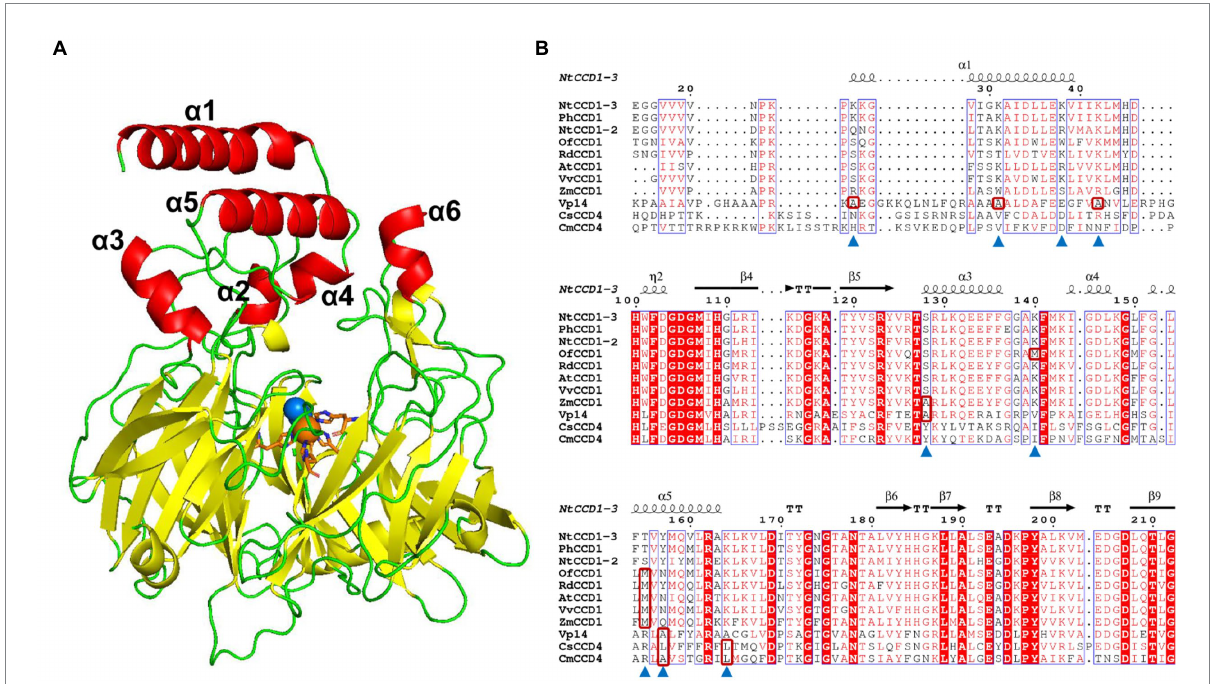
FIGURE 5 The simulated structure of NtCCD1-3 and its sequence alignment with other CCDs from different plants. (A) Structure of NtCCD1-3 simulated by SWISS-MODEL server. The Fe 2+ cofactor is shown as orange sphere, and the dioxygen binding with Fe 2+ are shown as blue spheres. The four conserved histidine residues binding to Fe 2+ are marked with orange sticks. (B) Amino acid sequence alignment of NtCCD1-3 with other plant- derived CCDs. The amino acid residues selected for site-directed mutagenesis are marked with blue triangles. The hydrophobic amino acids which the selected amino acid residues were mutated into are shown in the red boxes.